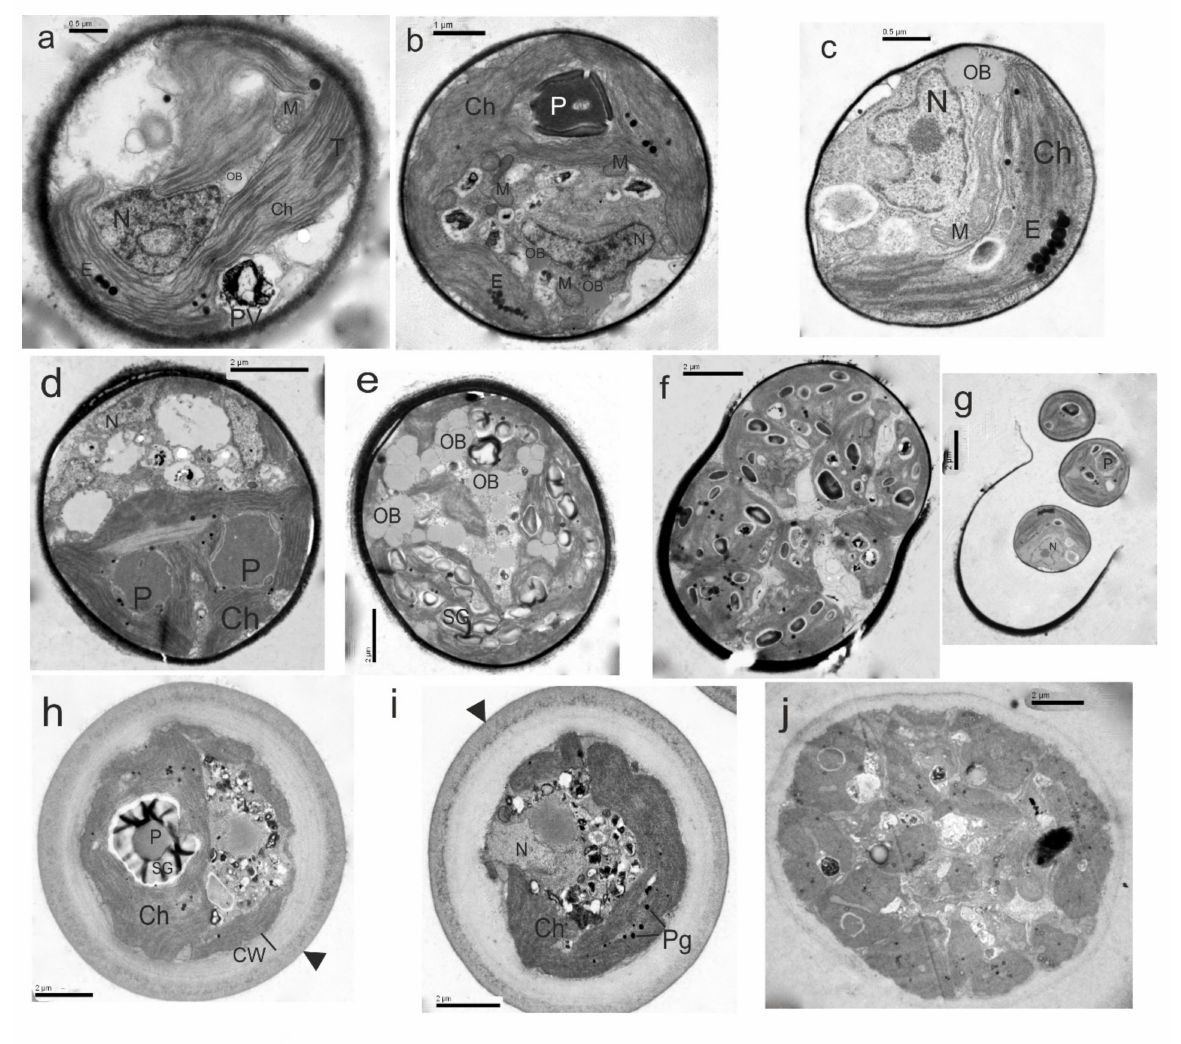
Figure 8. Electron micrographs of strains Spongiosarcinopsis limneus TAU-MAC 3310 ( a , b ), Lilaea pamvotia 3510 ( c – g ), Akraea chliaropsychia 0515 ( h – j ); ( a , b ): mature cells with eyespot, and pyrenoid surrounded by starch. ( c : mature cell with eyespot. ( d ): cell with two pyrenoids in the chloro- plast. ( e ): aging cell accumulating starch grains and oil bodies. ( f ): autosporangium with numerous autospores. ( g ): release of autospores. ( h , i ): mature cells covered with mucilaginous sheath (arrow- heads). ( j ): autosporangium with numerous autospores. Ch, chloroplast; CW, cell wall; E, eyespot; M, mitochondrion; N, nucleus; OB, oil body; P, pyrenoid; Pg, plastoglobuli; PV polyphosphate vacuole; SG, starch grain; T,